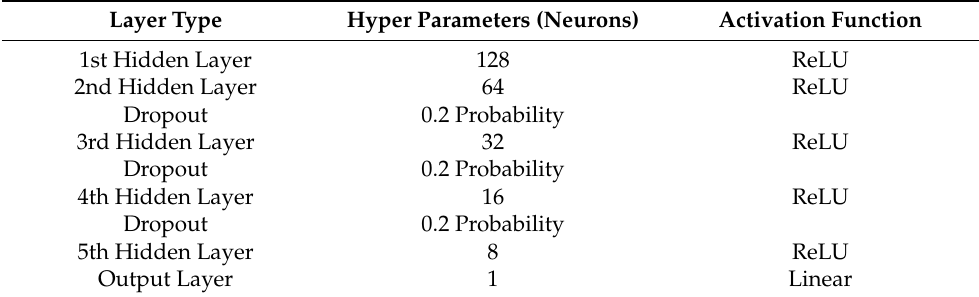
Table 1. FNN Network